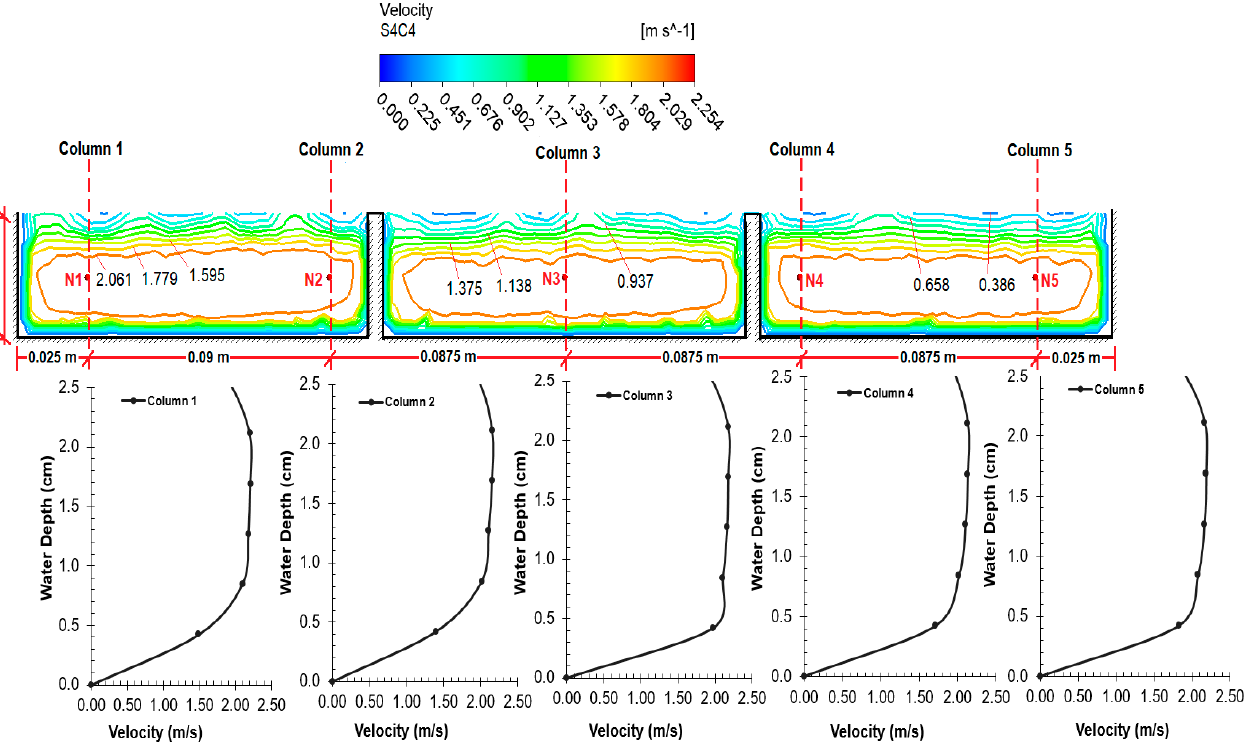
Figure 18. CFD velocity contours and depth-velocity distributions for Cross-section 4.